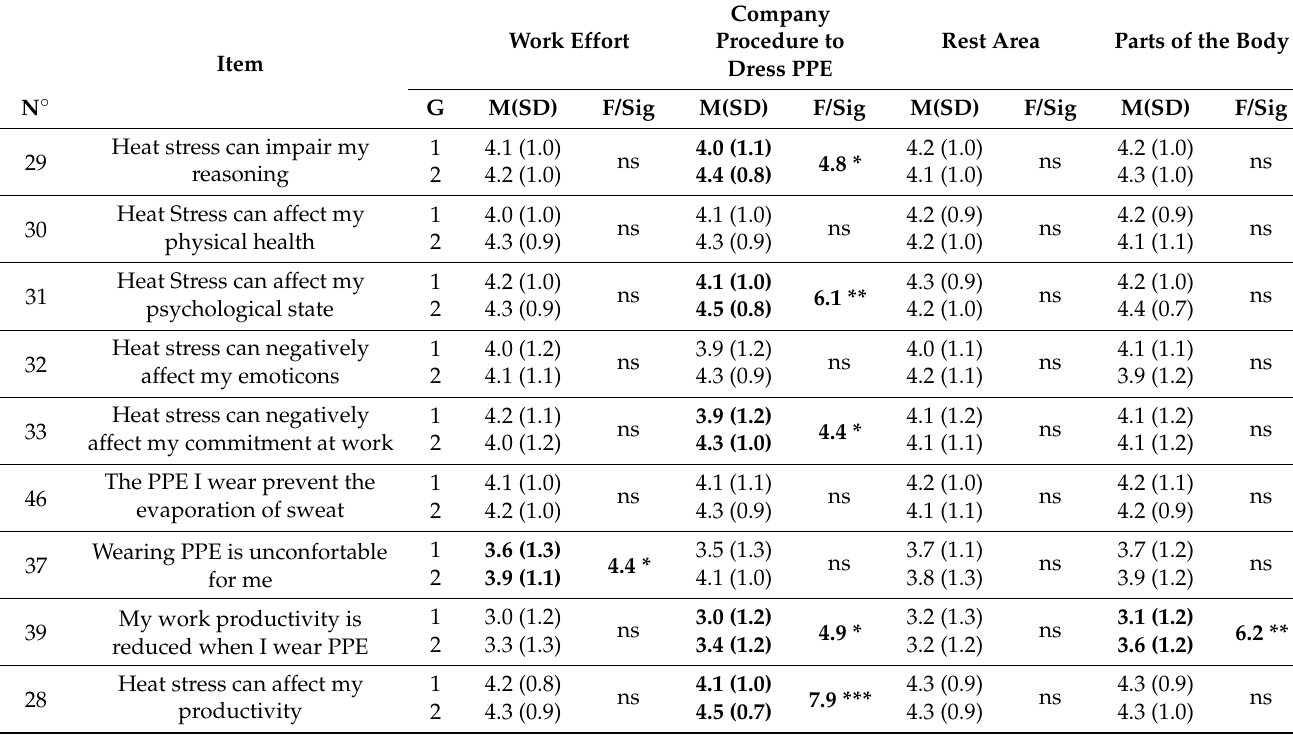
Table 4. Difference between groups concerning issues related to the effects of the heat stress on workers and their productivity loss